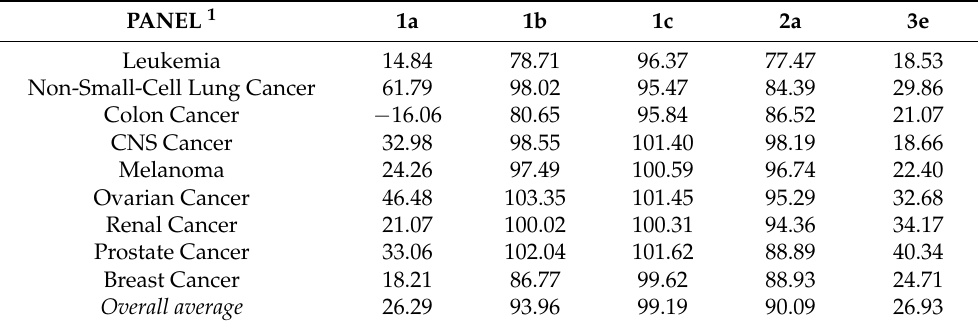
Table 4. G% values determined for the five selected compounds against the NCI60 panel with the one-dose